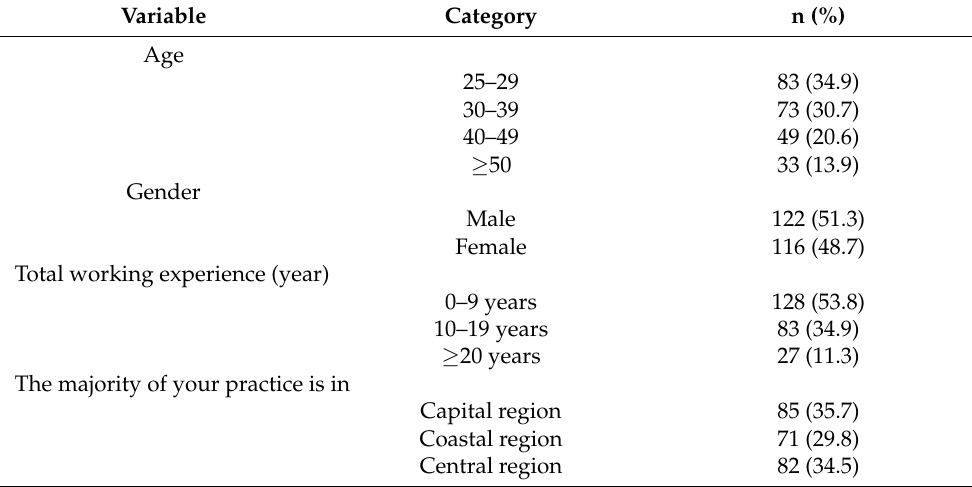
Table 1. Obstetricians’ demographic characteristics.